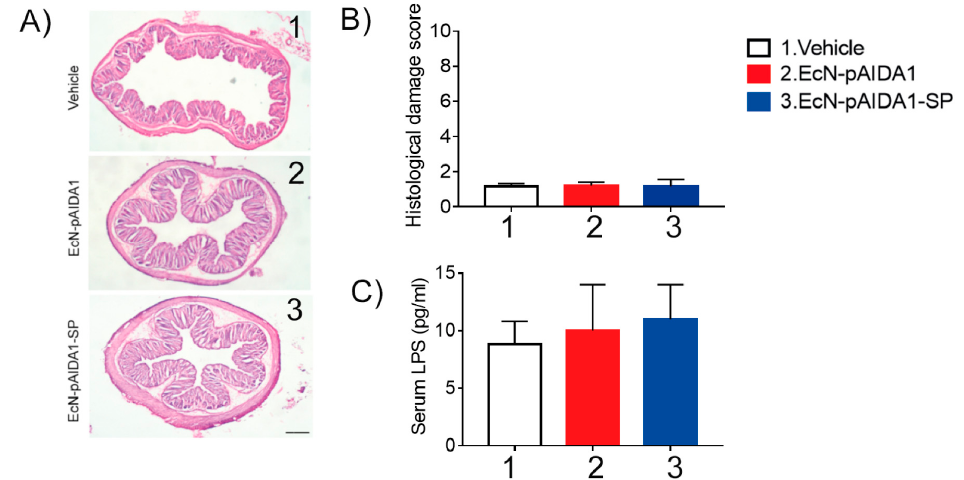
Figure 7. Representative images of hematoxylin-and-eosin (H&E) stained colon sections ( A ) and relative histological damage score showing the effect of the EcN-pAIDA1-SP ( B ); magnification 4×; samples collected at t = 16 weeks. Serum levels of LPS after oral administration of control, EcN-pAIDA1, and EcN-pAIDA1-SP; samples collected at t = 16 weeks ( C ). Results are expressed as mean ± SD of n = 4 experiments performed in triplicate.